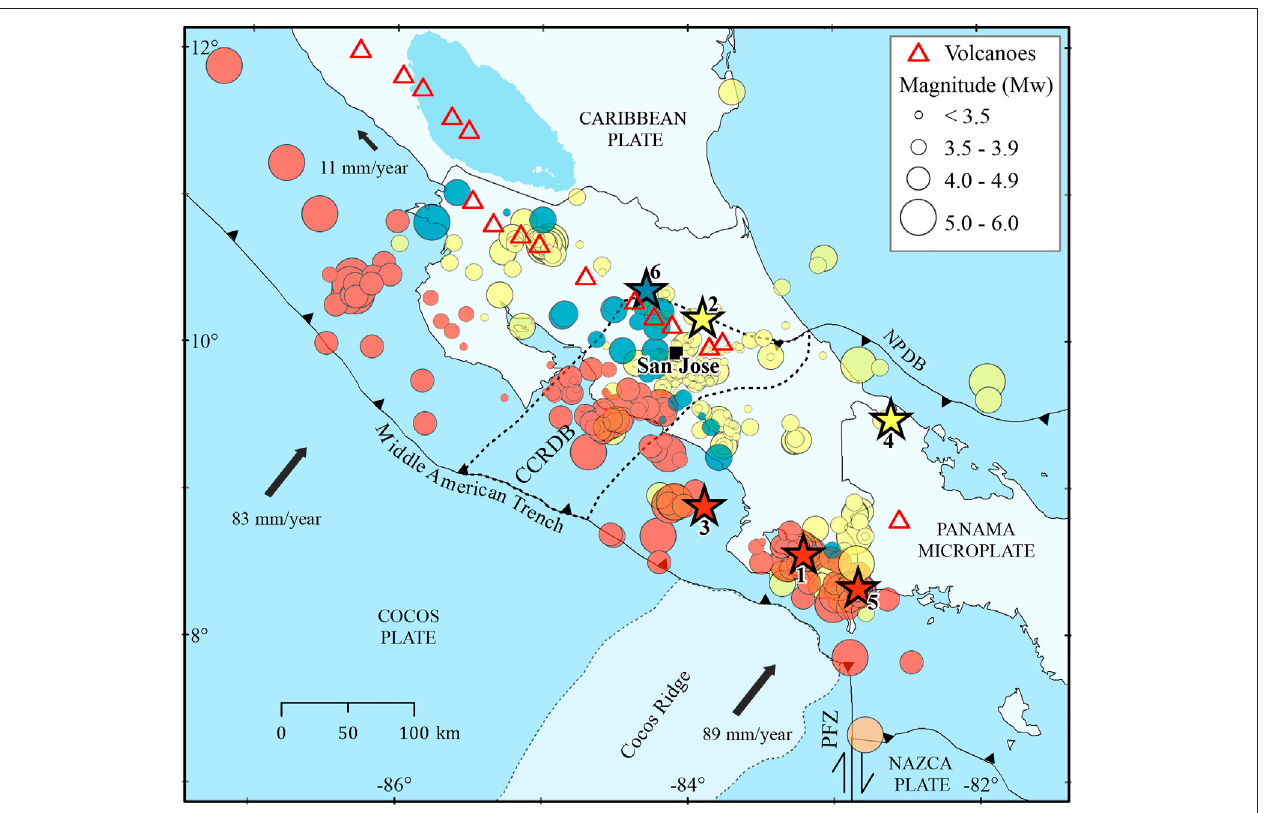
FIGURE 1 | Tectonic framework of Costa Rica and felt earthquakes during 2018 and 2019, as reported to RSN. The origin of the earthquakes is differentiated by color: red interplate subduction, orange Panama Fracture Zone, yellow shallow crustal earthquakes, and blue intraslab subduction earthquakes. The region contained within the dotted lines represents the central Costa Rica Deformed Belt (CCRDB).The dashed line represents the simpli fi ed northeast boundary ofthe CentralAmerican Forearc Block along the Volcanic Arc Faults (VAF). The numbered stars represent the earthquakes shown in Table 1 . The largest events, 1 and 5, are examined in detail. Volcanos in the region are indicated by red